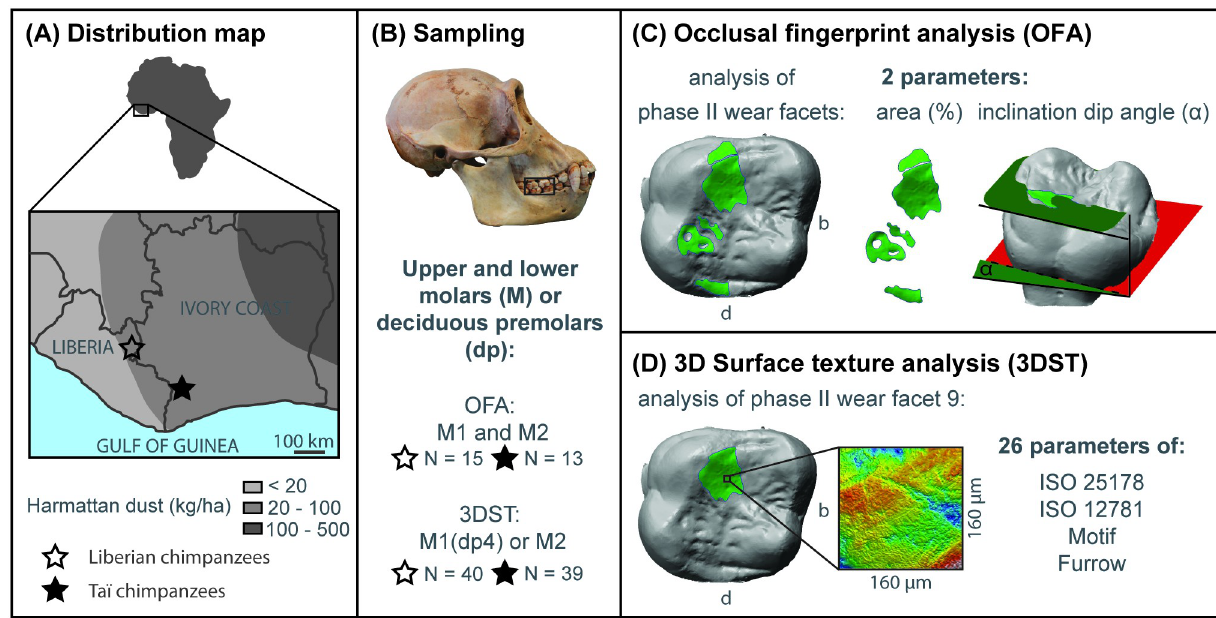
Fig 1. Distribution map and methodological setup. Map with the distribution range of the Liberian chimpanzee population, the locality of the Ta ї National Park (Ivory Coast) and the distribution of Harmattan dust loads in those areas (A). The map and the Harmattan distribution was redrawn and adapted according to the data presented in Lesschen et al. [45]. Sampling procedure (B) for occlusal fingerprint analysis (macroscopic tooth wear) (C) and 3D surface texture analysis (microscopic tooth wear) (D) shown for the upper first molar (b = buccal, d = distal).